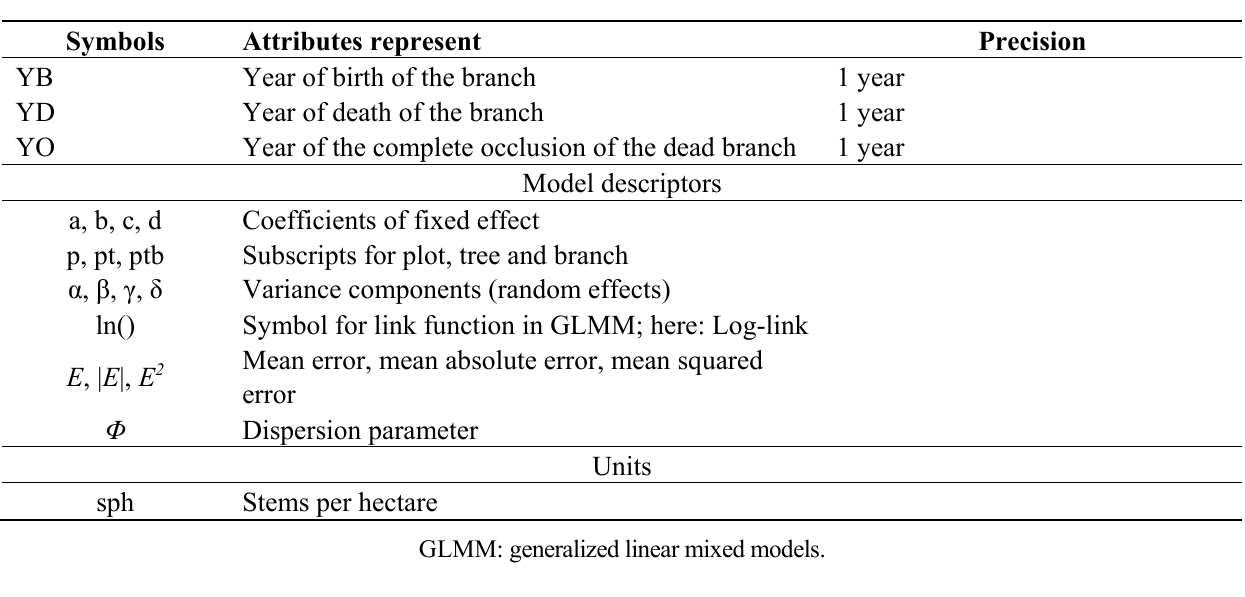
Table 2. Plot and tree characteristics of Betula alnoides plantations.